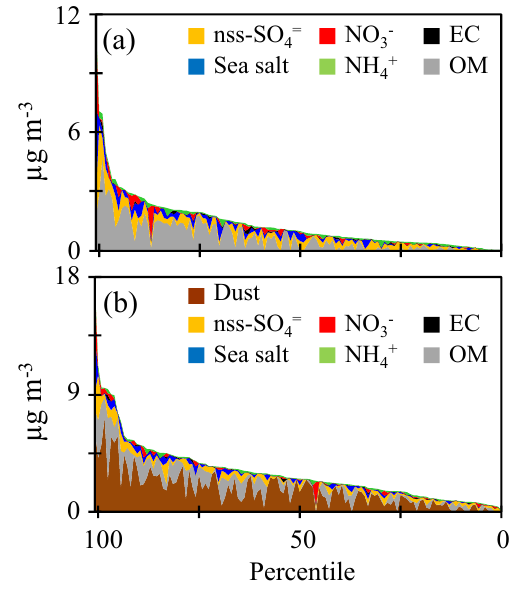
Figure 10. Contribution of each aerosol specie to bulk PM 10 in samples collected at Izaña under westerly airflow conditions; data classified from the highest to the lowest levels. (a) Considering ma- jor components except dust. (b) Considering all major components including mineral